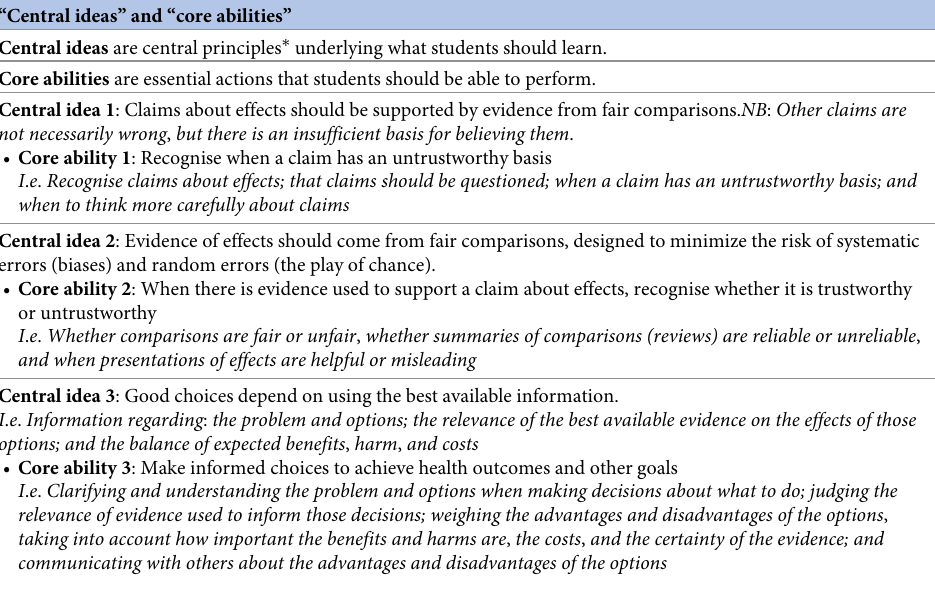
Table 4. Central ideas and core tasks.